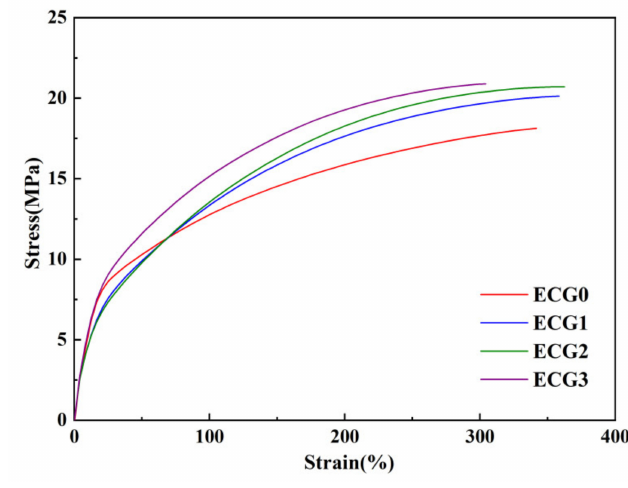
Figure 11. Stress-strain curves of CNT/GNP/EUG